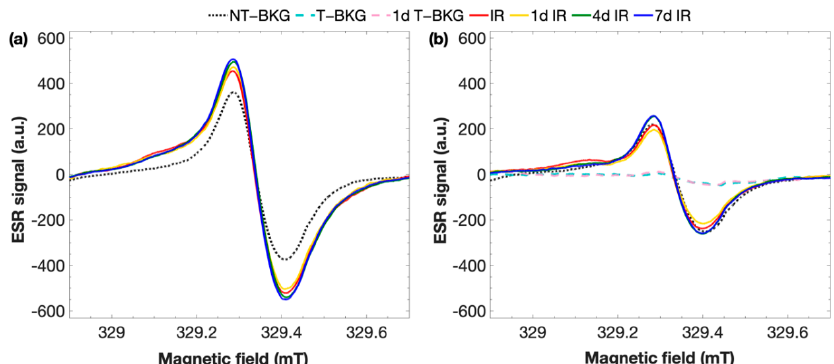
Figure4. EvolutionoftheESRspectrarecordedatdi ff erenttimesin( a )non-chemicallyand( b )chemically treated samples exposed to 20 Gy of 137 Cs γ -rays following storage in the freezer. The NT − BKG, T − BKG, and IR have the same notations as in Figure 3.